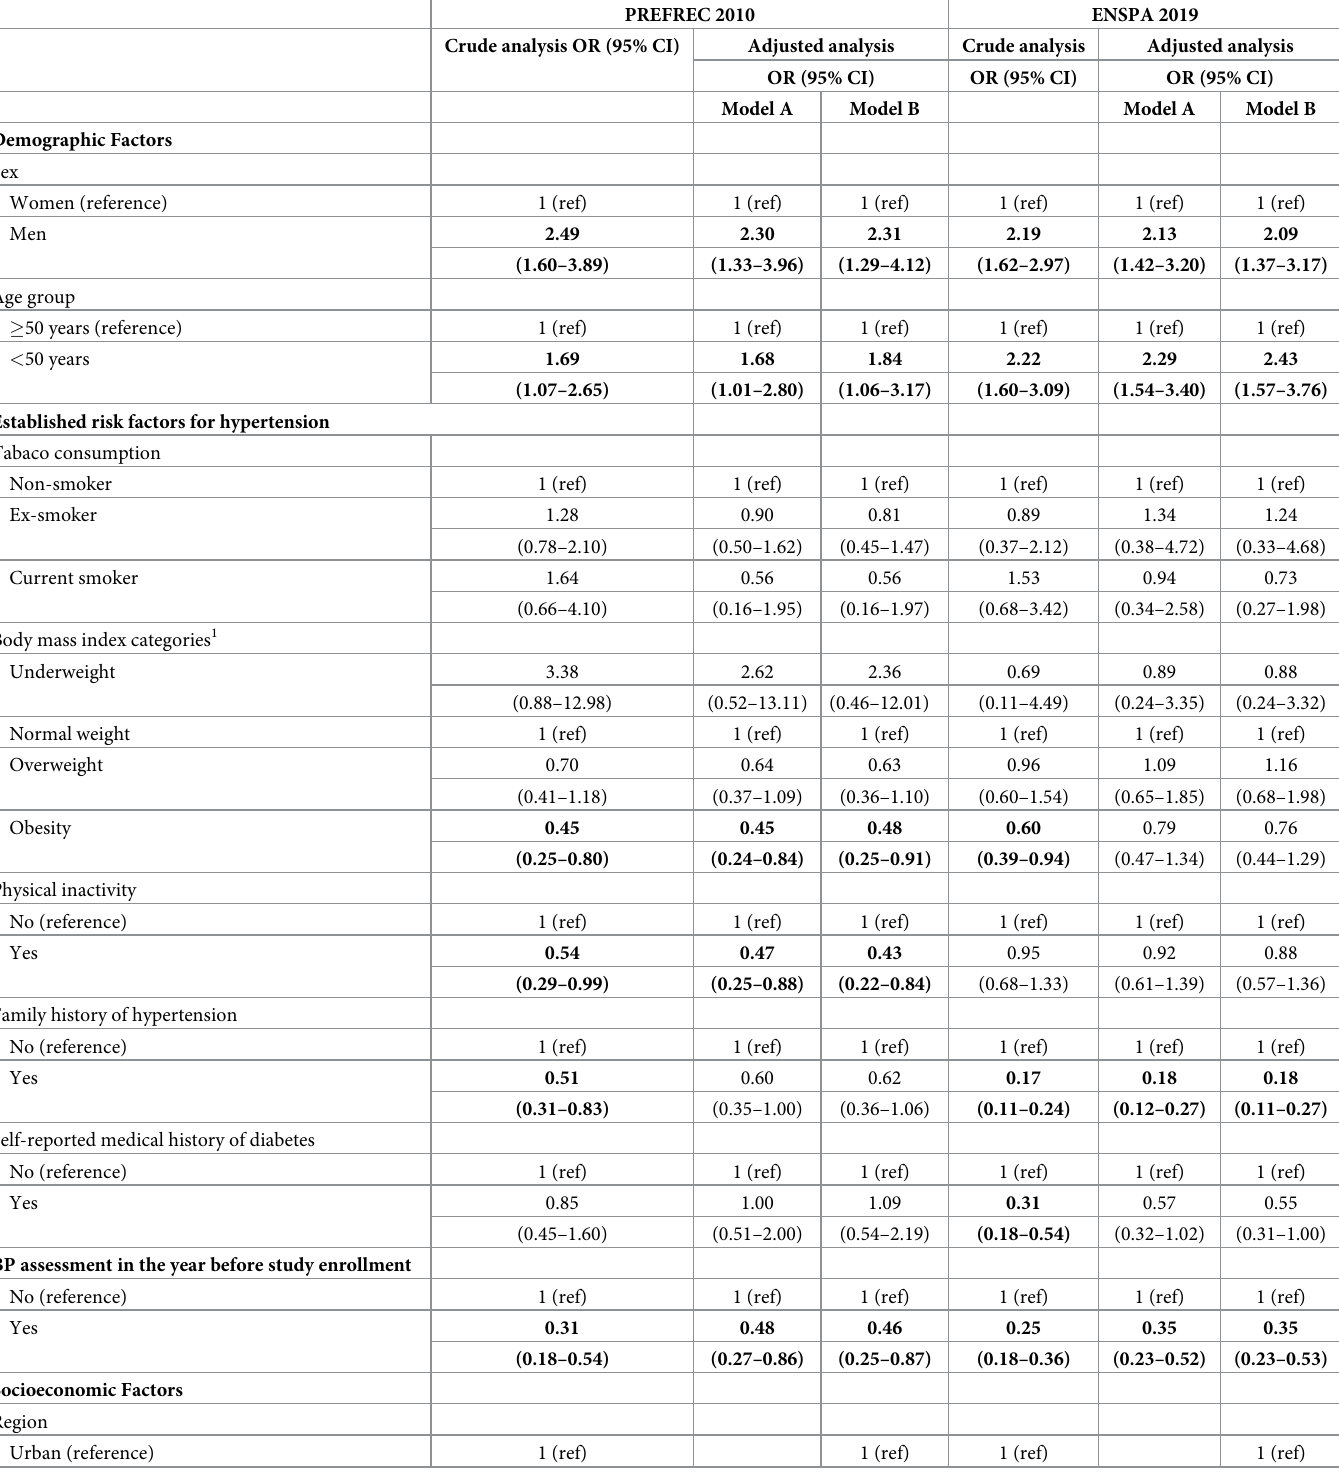
Table 2. Crude and adjusted logistic regression analysis of hypertension unawareness (SBP/DBP � 140/90 mmHg without a self-reported medical history of hyper- tension) in hypertensive individuals aged between 30 and 75 years by the study year (PREFREC 2010 and ENSPA 2019) in the provinces of Panama and Colon. Odds ratio (OR) and 95% confidence intervals